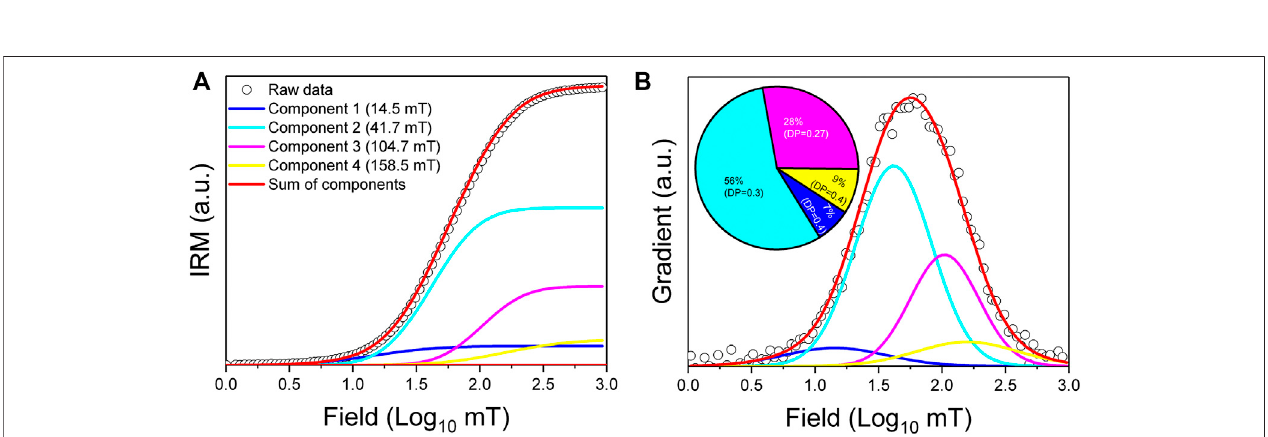
FIGURE10| IRMcomponentanalysisbasedonsupervisedunmixingwithinformationfrommagneticmineralassemblagesidenti fi edfromSEMandTEManalyses. (A) Linear acquisition plot. (B) Gradient of acquisition plot. Four CLG components are required to fi t the IRM acquisition curve: raw data (black circles), component 1 (blue),component2(cyan),component3(purple),component4(yellow),andthesumofthefourcomponents(red). B c, 1/2 values(theacquisition fi eldatwhich50%ofthe IRMisreached)foreach coercivityfraction areindicated inparentheses in (A) .Thedispersionparameter (DP,i.e., IRMcoercivitydistributionwidth)and remanence contribution for each coercivity fraction are indicated in the pie chart in (B)